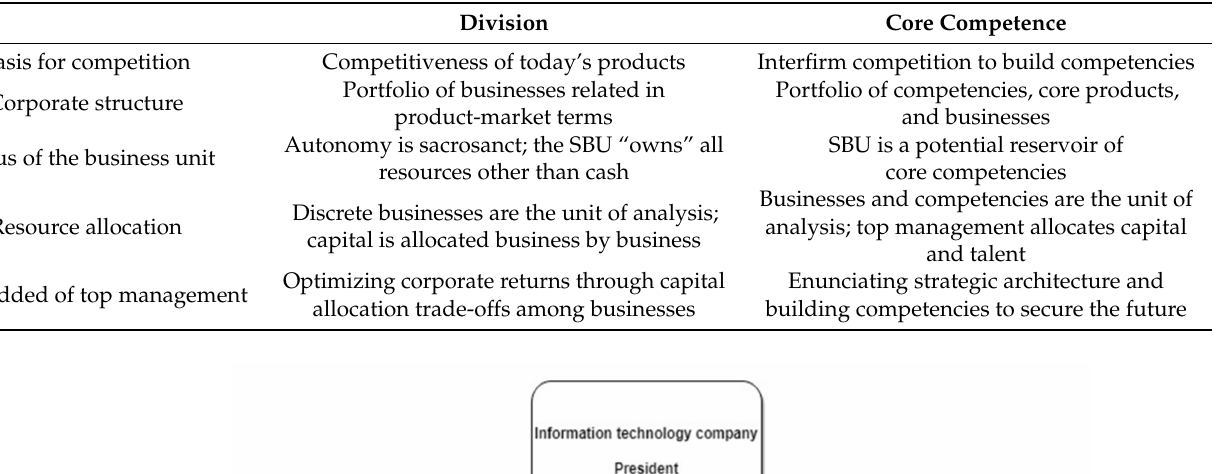
Table 1. Two concepts of the corporation: SBU or core competence.